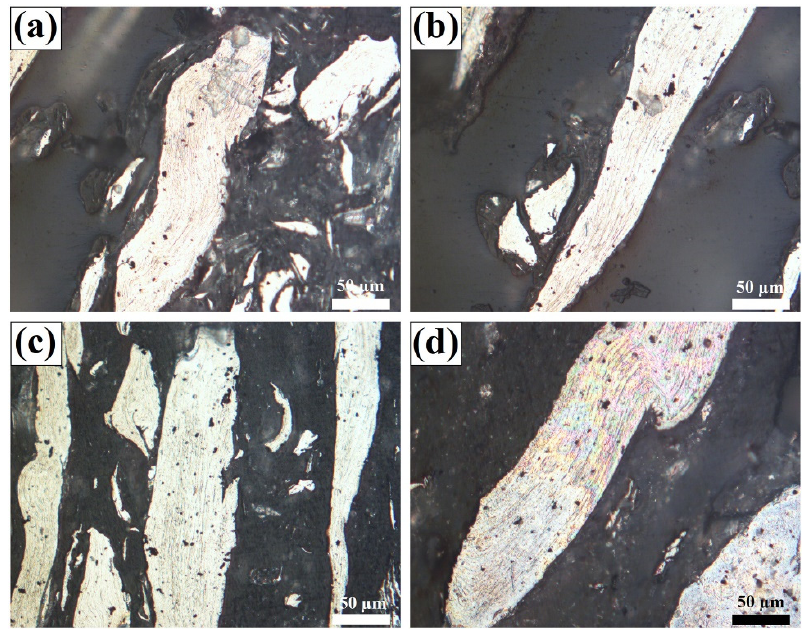
Figure 9. Effects of processing parameters on the grain structure of metal fragments in the polymer matrix joint: ( a ) w = 800 rpm- v = 30 mm/min, ( b ) w = 800 rpm- v = 50 mm/min, ( c ) w = 1000 rpm- v = 30 mm/min, and ( d ) w = 1000 rpm- v = 50 mm/min. Reprinted with permission from Ref. [72]. 2021, S.M. MirHashemi et al.